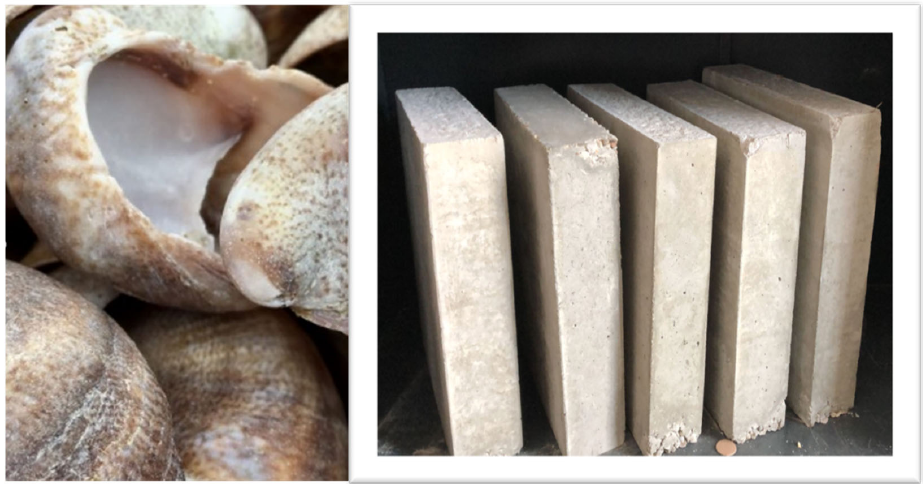
Figure 3. Scallop shell concretes prepared for this study.